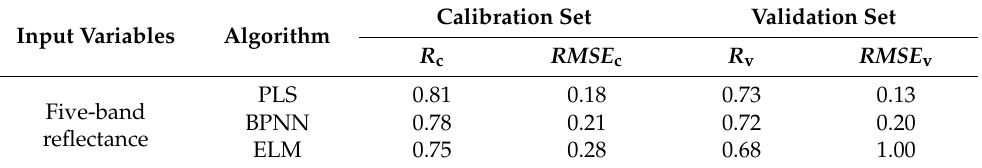
Table 6. CNC prediction results with PLS, BPNN and ELM based on the five-band reflectance.